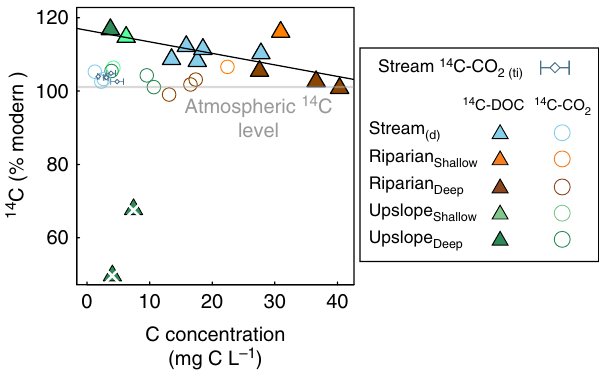
Fig. 3 Mass controls on 14 C-CO 2 and 14 C-DOC in groundwater and stream water. Scatterplot showing the groundwater and stream water 14 C-CO 2 and 14 C-DOC in %modern as a function of their respective concentrations in mg C L − 1 . The solid line represents the least square linear regression model 14 C-DOC = DOC × − 0.31 + 116.6, R 2 = 0.45, p = 0.01, excluding the two severely depleted 14 C-DOC values from the upslope deep location in August and October identi fi ed with the white cross. The grey line